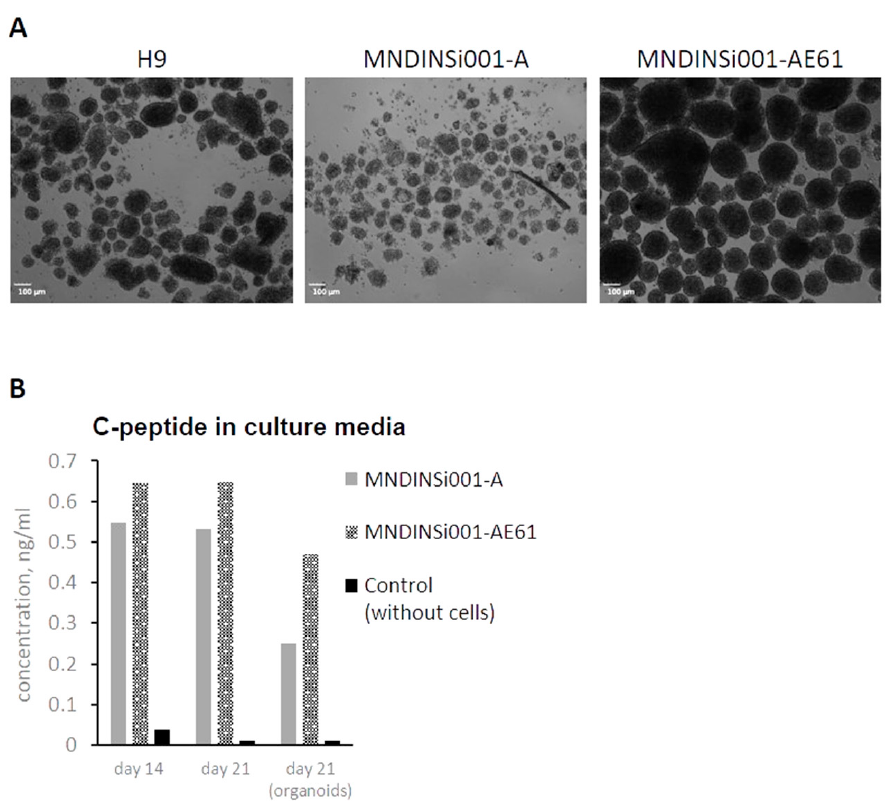
Figure 3. Organoid formation and C-peptide secretion at late stages of pancreatic differentiation in an isogenic system. ( A ) Abnormal organoids generated from MNDINSi001-A (mutant) cells compared with ones generated from isogenic control MNDINSi001-AE61 (CRISPR/Cas9-corrected) cells at day 21 of pancreatic differentiation. H9 ESC line was used as a gold standard. ( B ) MNDINSi001-A (mutant) and MNDINSi001-AE61 (CRISPR/Cas9-corrected) beta-like cells secreted C-peptide into culture media at days 14 and 21. Data are shown for the representative differentiation